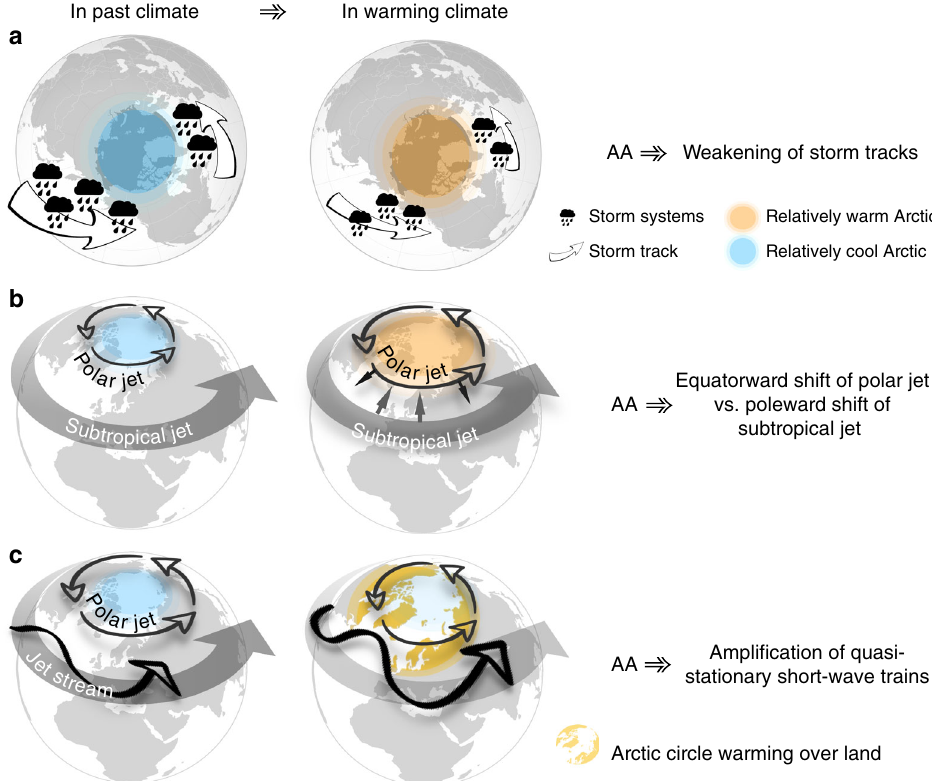
Fig. 3 Schematic representation of proposed dynamical mechanisms in summer. a Weakening of storm tracks, b latitudinal-shift in jet positions, and c ampli fi cation of quasi-stationary waves (Figure created using Apple ’ s Keynote software)